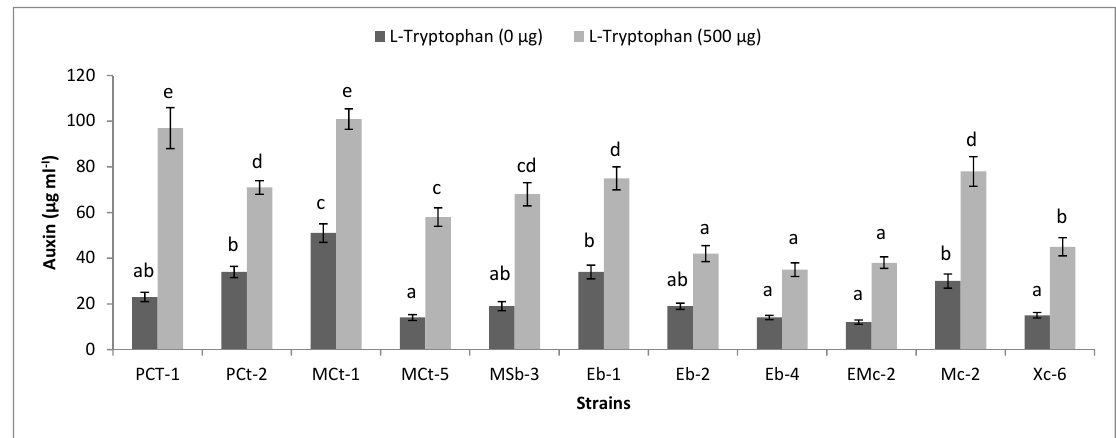
Figure 3. Auxin production by some representative purified bacterial strains in the presence and absence of L ‐ tryptophan. Strains were grown in Luria–Bertani broth (L ‐ broth) at 37 °C for 72 h. Bar represents the mean ± S.E. of three replicates. Different letters on bars indicate significant differences between respective treatments using Duncan’s multiple range test ( p ≤ 0.05).